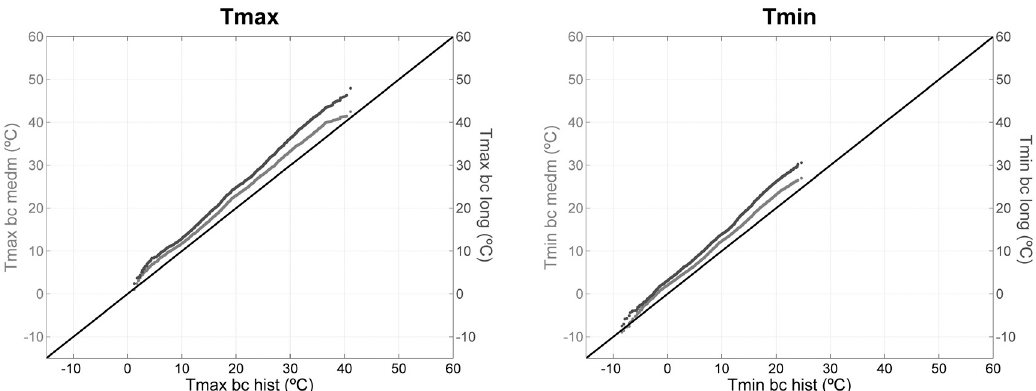
Figure 7. Quantile–quantile plot of the historical period (bc hist, x-axis) vs. the medium-term future (bc medm, medium grey, left y-axis) and the long-term future (bc long, dark grey, right y-axis), for daily maximum and minimum temperature (Tmax and Tmin, °C) (left and right, respectively) for Madrid. Black solid line represents similar x-axis and y-axis quantiles.